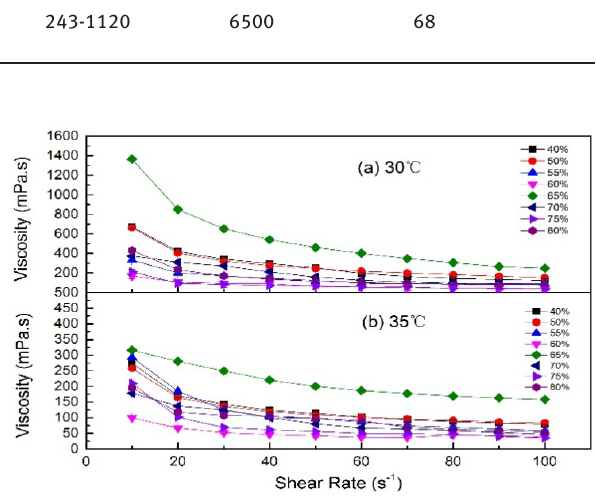
Figure 1: The influence of polymer concentration (315mg/L ) on rheological behaviors at the temperatures (a) 30